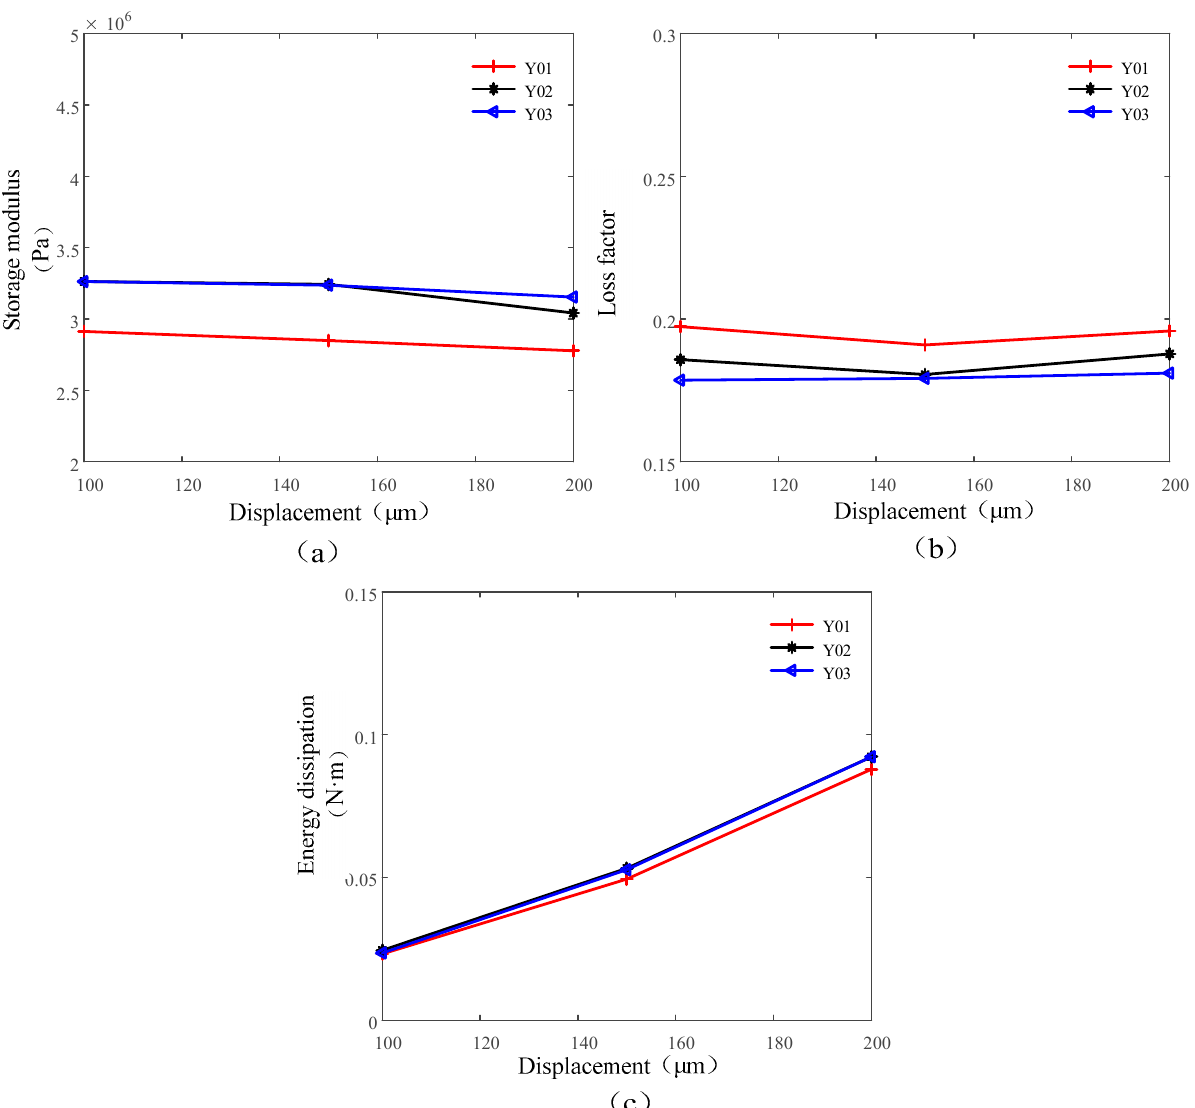
Figure 12. Dynamic parameters of specimens Y01~03 vary with displacement at 1 Hz: ( a ) storage modulus, ( b ) loss factor, and ( c ) energy dissipation.